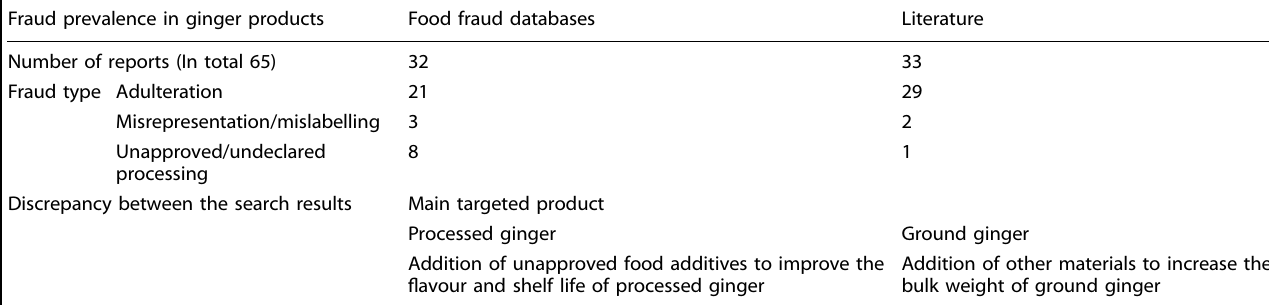
Table 5. The summarization of the fraud prevalence from two